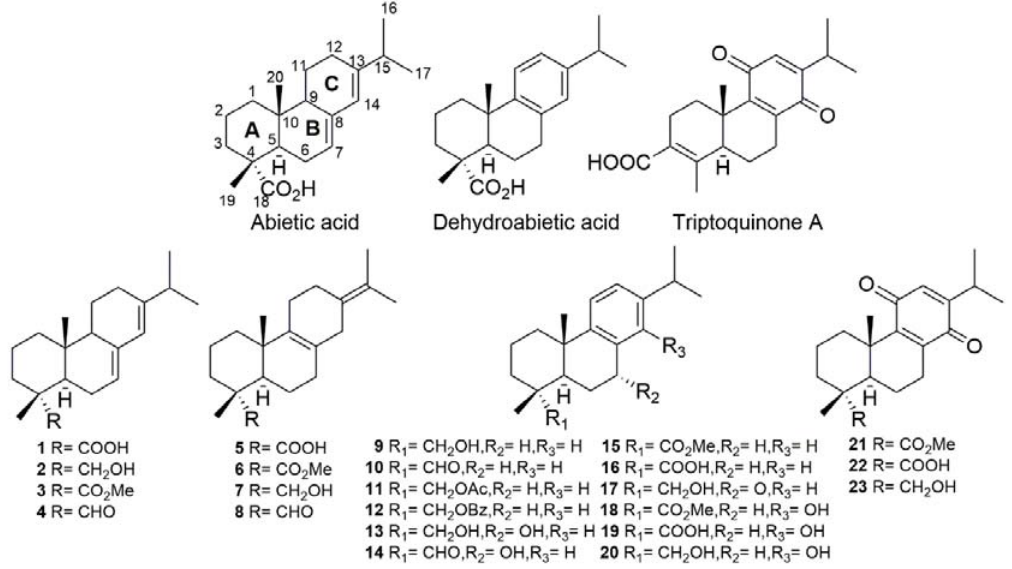
Figure 1. Bioactive and tested abietanes: abietanes 1 – 8 , dehydroabietanes 9 – 20 and triptoquinones 21 – 23